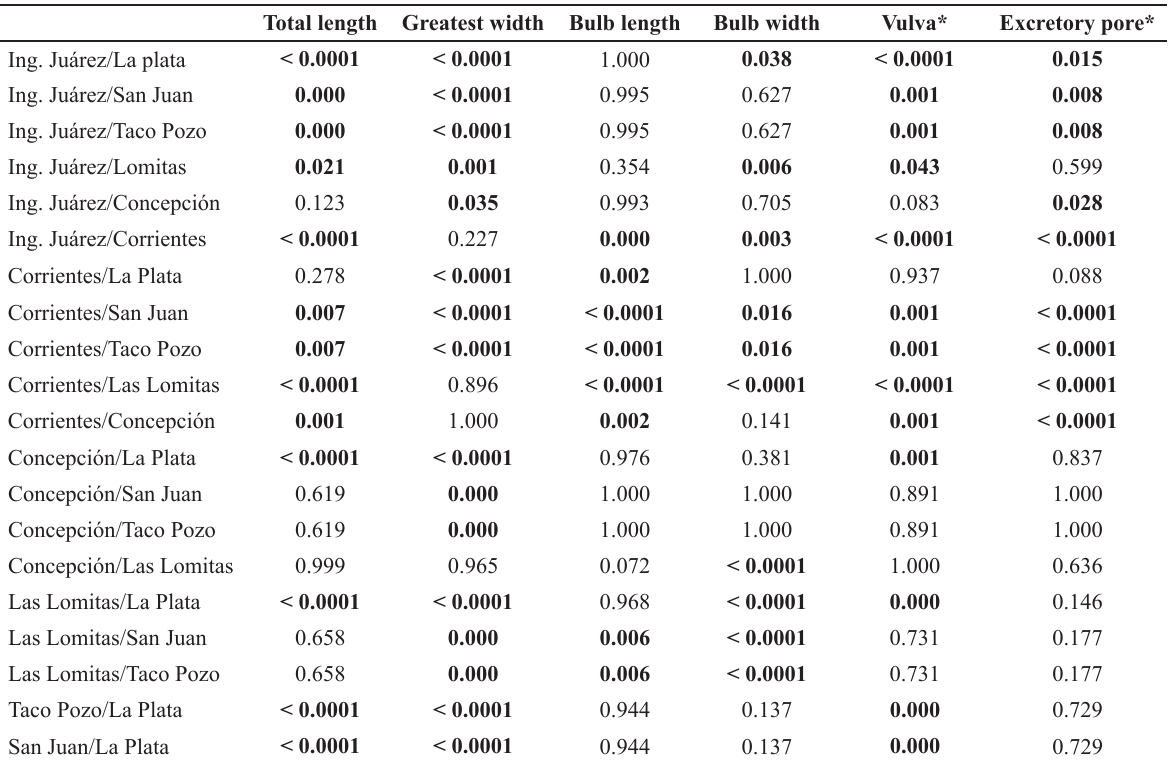
P values for pair comparisons of morphological features of females of A. hylambatis from different localities in Argentina. Significant values in